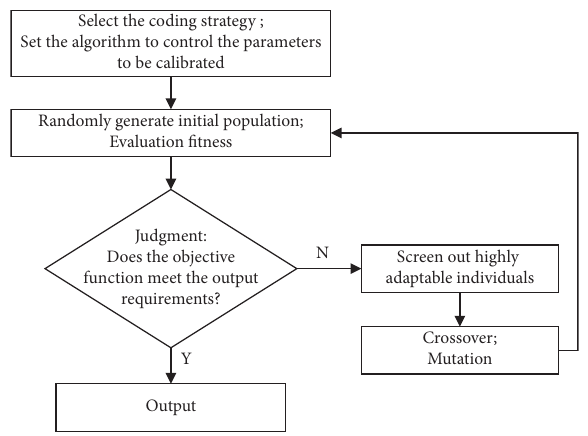
Figure 6: Basic steps of genetic algorithm.